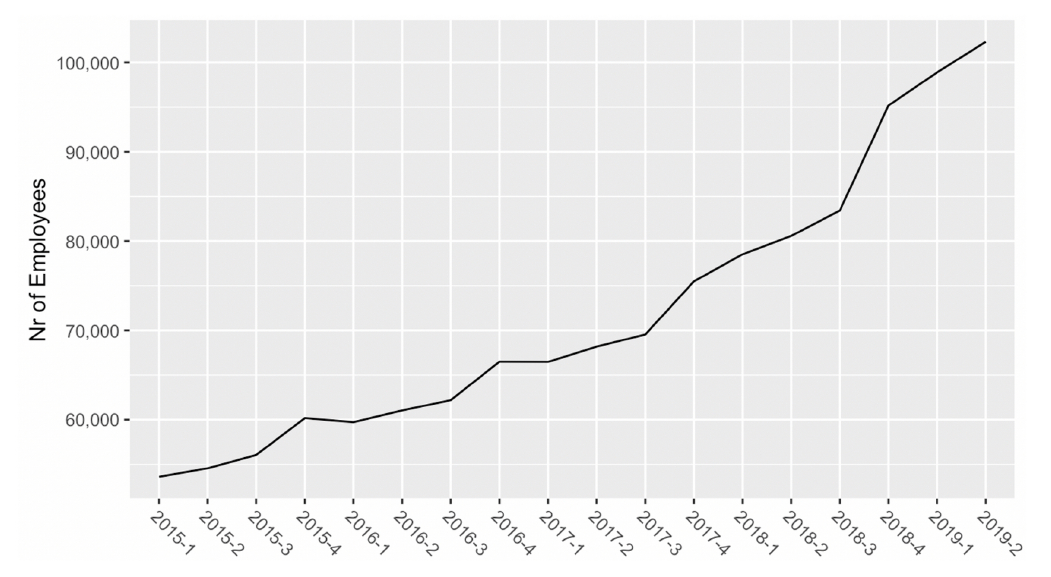
Figure 4: Trend in total number of statutory employees in parcel delivery industry nationally, 2015–2019. Data from Quarterly Census of Employment and Wages,